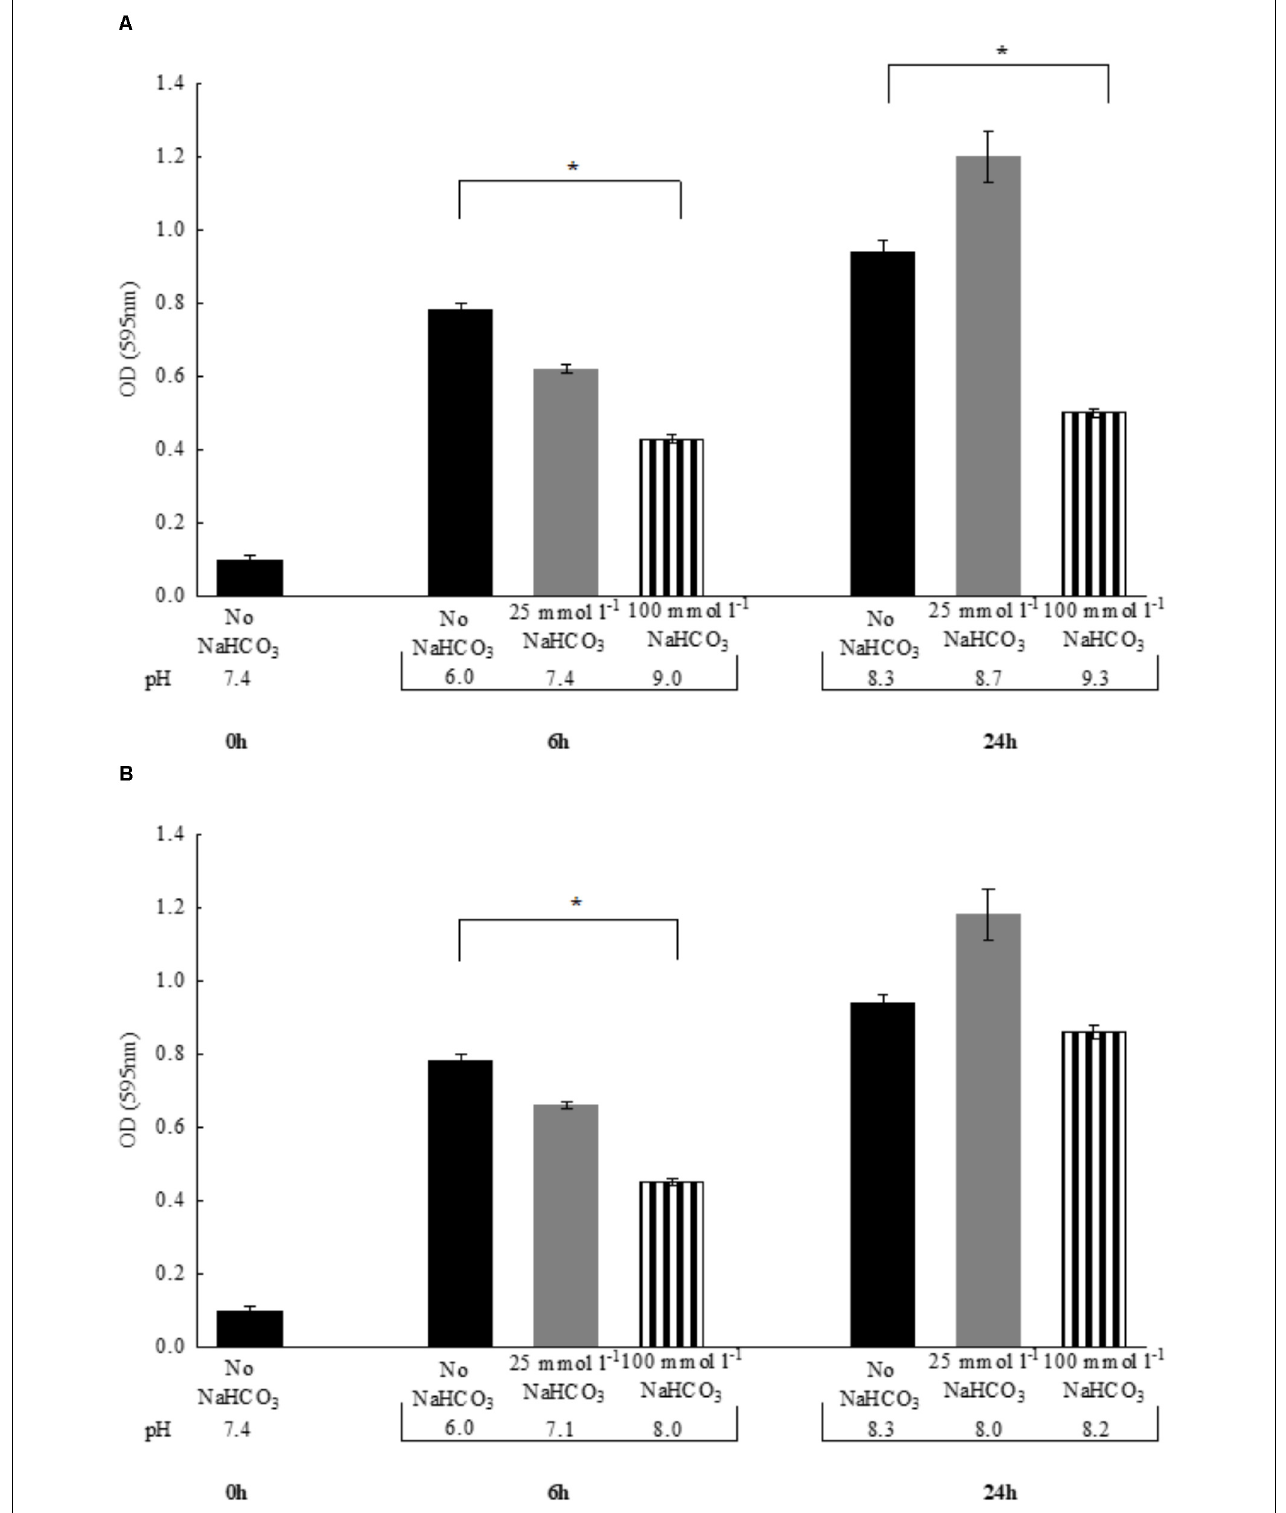
FIGURE 3 | Changes in bacterial density of Staphylococcus aureus and media pH following 6 vs. 24 h incubations either (A) in air atmosphere or (B) in the presence of appropriate CO 2 levels. Black bars: NaHCO 3 -free controls, gray bars: 25 mmol l − 1 NaHCO 3 , striped bars: 100 mmol l − 1 NaHCO 3 . ∗ P < 0.05.